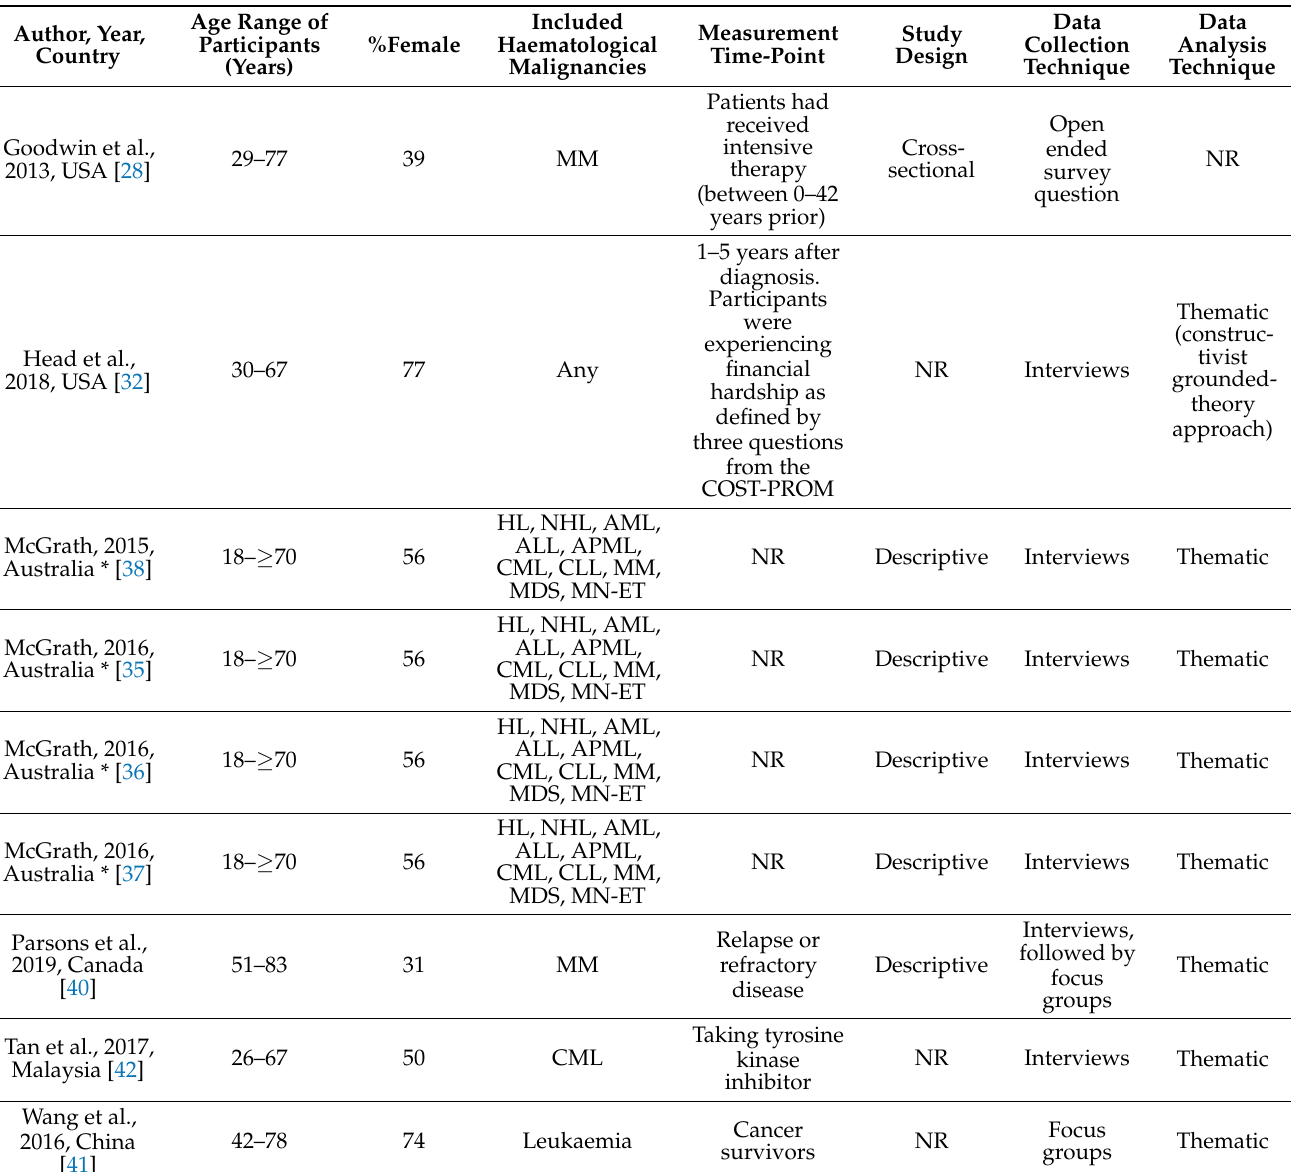
Table 2. Included qualitative